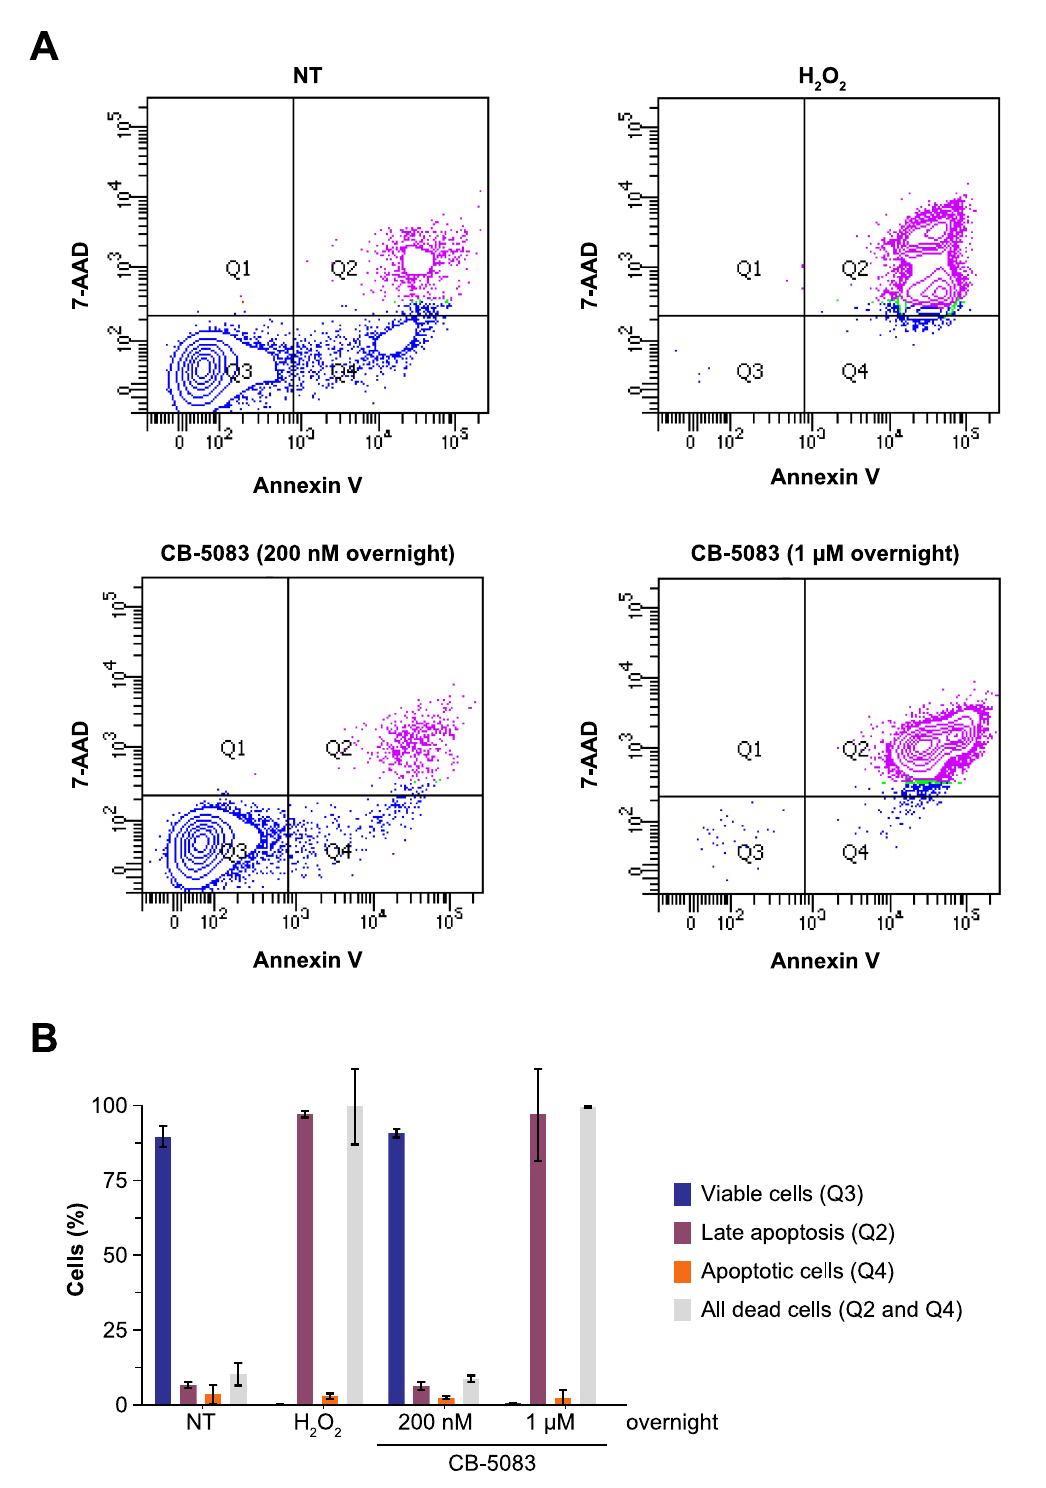
Fig 3. Inhibition of VCP induces apoptosis in AML cells. (A) MV4-11 cells were treated with 200 nM or 1 μ M CB-5083 overnight. Cells that were left untreated or treated with 500 mM H 2 O 2 served as control. Induction of apoptosis was assessed by dual staining with Annexin V and 7-AAD. Relative fluorescence of Annexin V and 7-AAD is shown for all conditions. (B) Quantification of the data.